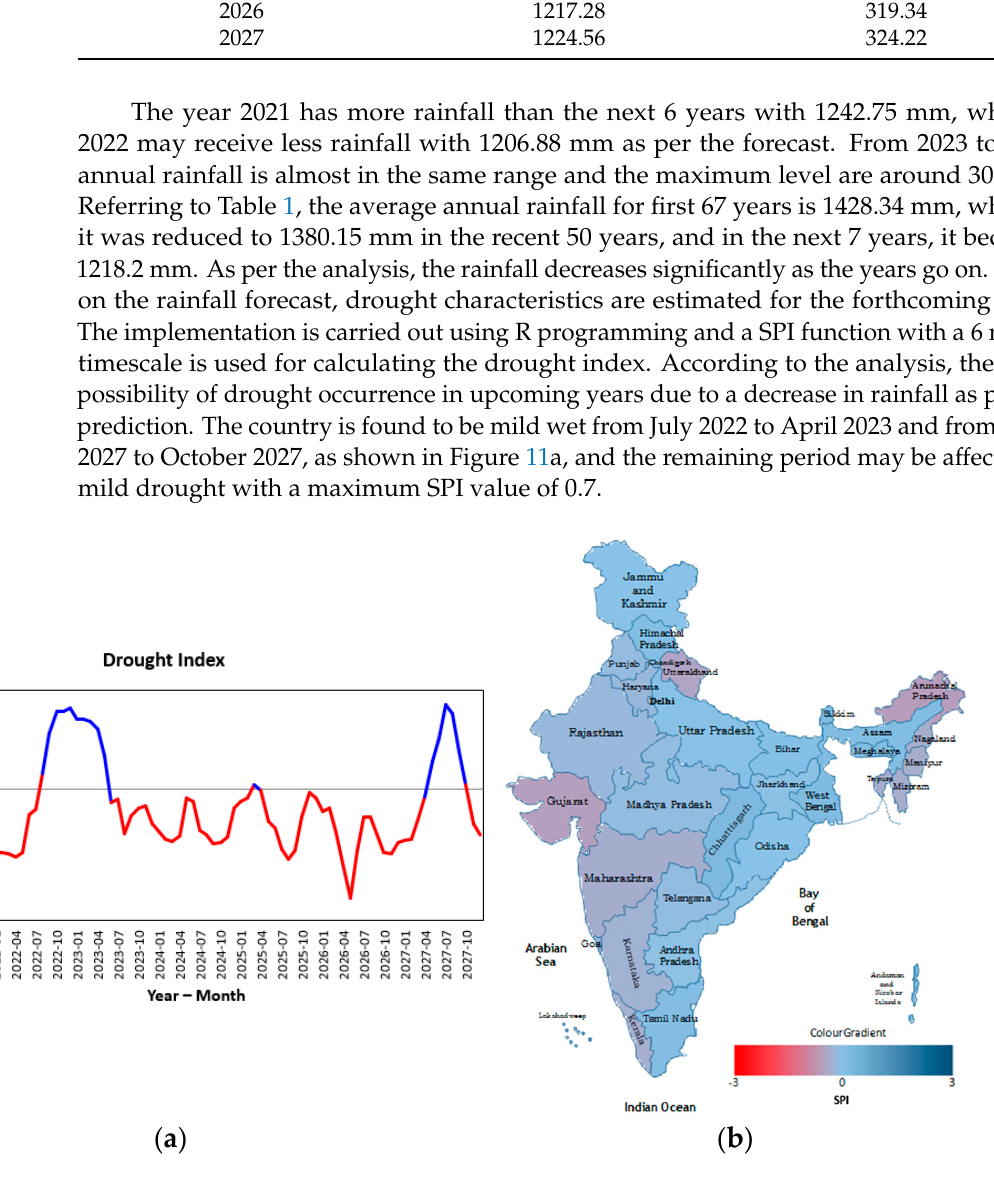
Figure 11. Drought forecast of India from 2021 to 2027. ( a ) SPI values for the forecasted period. ( b ) Forecasted drought status in several regions of the country (Source for template: https://in-dzara.com/wp-content/uploads/2013/04/indzara_Geographic_Heat_Map_India_v4.xlsx (accessed on 4 December 2022).